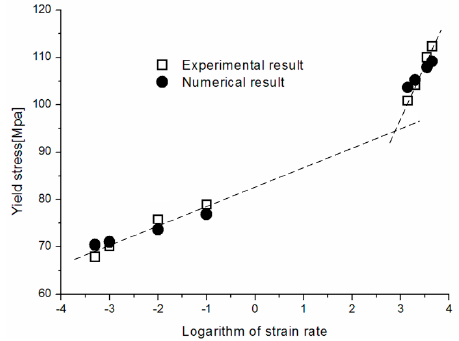
Figure 12. Numerical predictions and experimental results of yield stresses of PC.